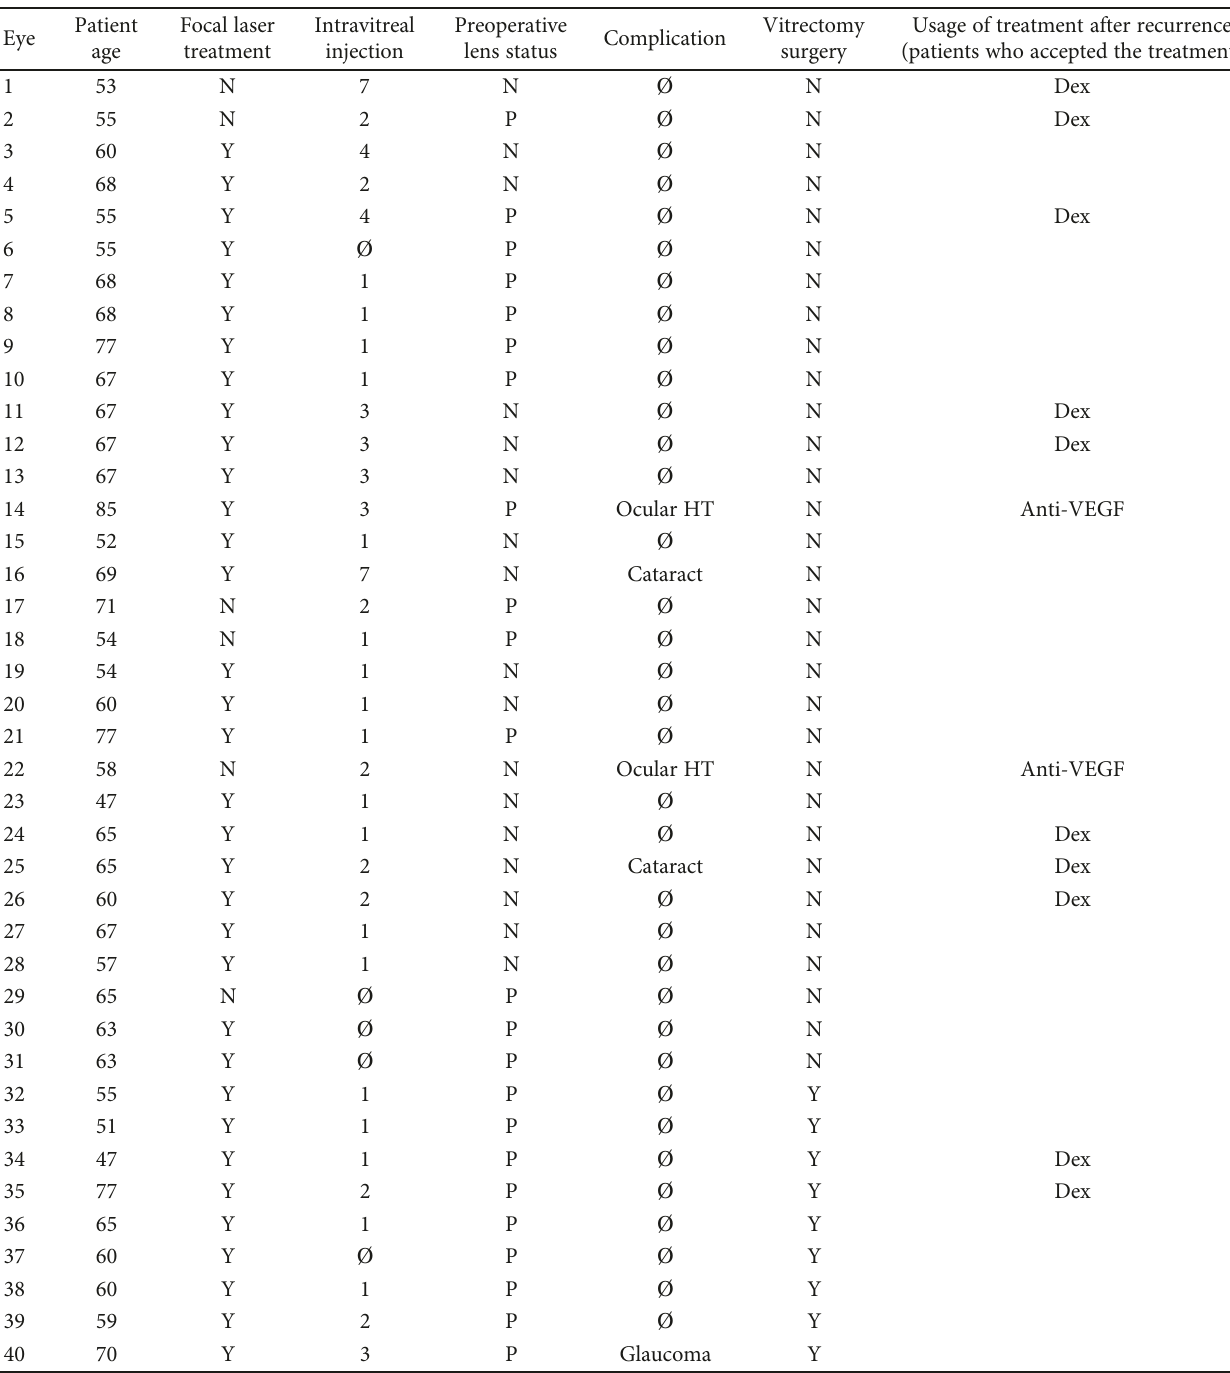
Table 1: Results of the current